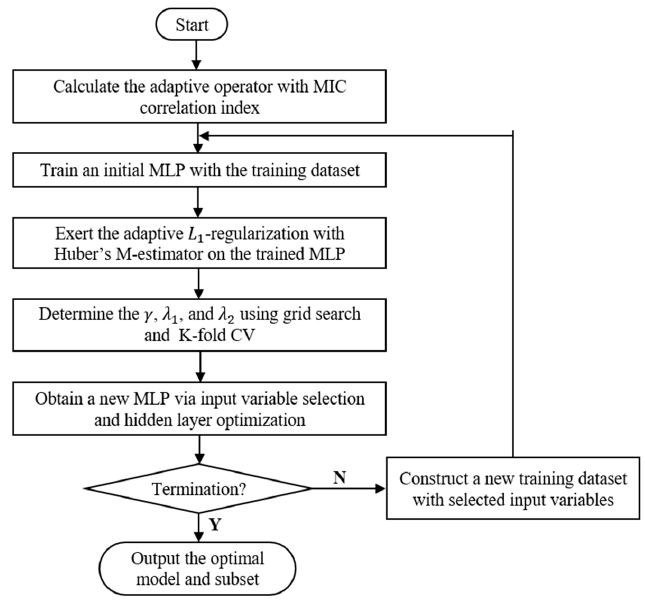
Figure 3. Flowchart of the proposed ARdLASSO-MLP.